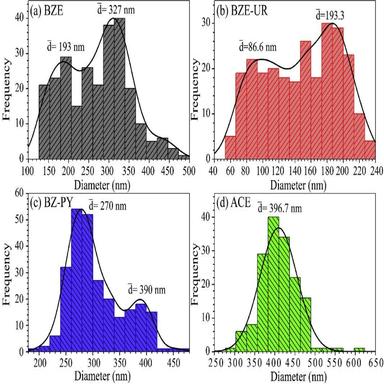
Diameter or width distribution of nitrogen-doped carbon fibers. (a) BZE, (b) BZE-UR, (c) BZ-PY, and (d) ACE. The mean fiber diameter or width is indicated. N-CFSs synthesized using acetonitrile ethanol showed the largest mean diameter (396.7 nm). BZ-PY, pyridine-benzylamine; ACE, acetonitrile-ethanol; BZE-UR, BZE saturated with urea; BZE, benzylamine-ethanol, N-CFS, nitrogen-doped carbon fiber sponge.